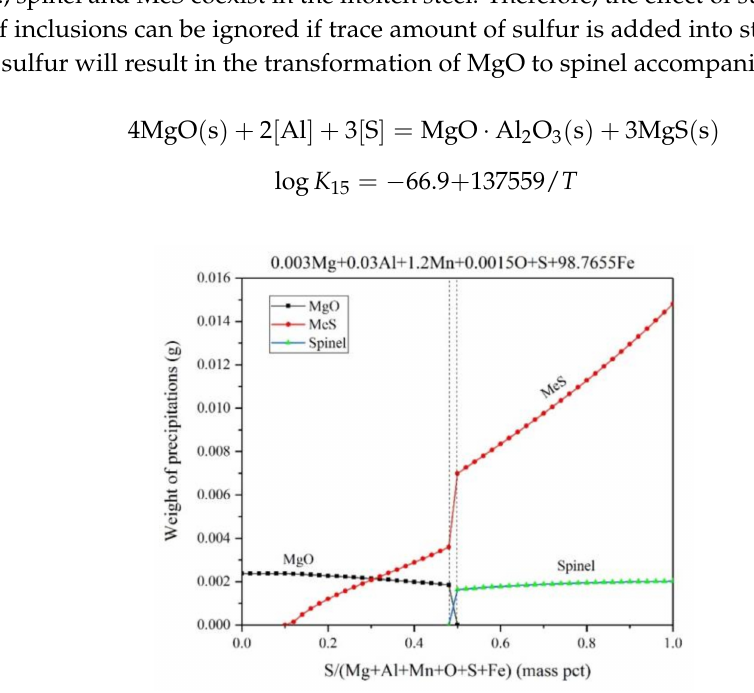
Figure 8. Effect of sulfur addition on the evolution of inclusions after magnesium addition (MeS: Mg 0.9 Mn 0.1 S, Spinel: MgAl 2 O 4